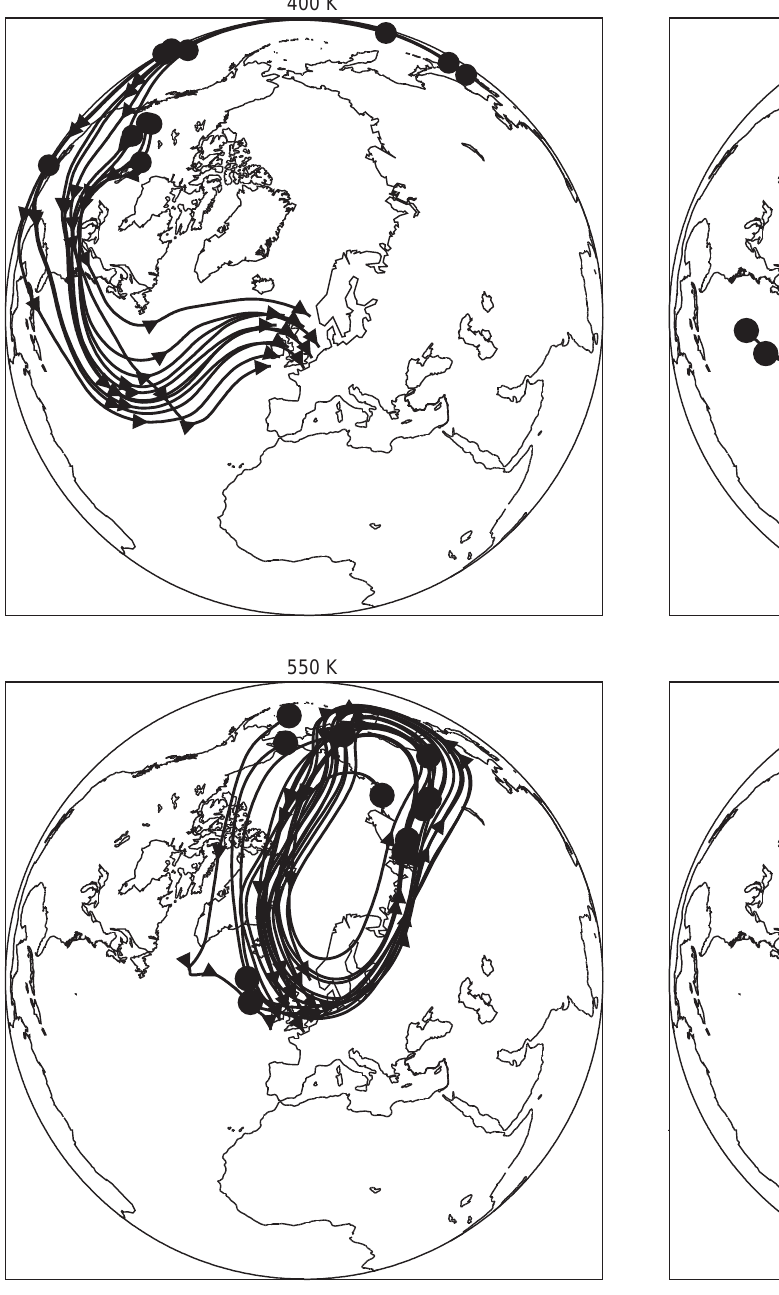
intervals of 2.5 days along each trajectory, with arrow heads also at the end points, coinciding with positions over the UK The calculations are for the potential temperature surface h (cid:136) 400 K, 475 K, 550 K and